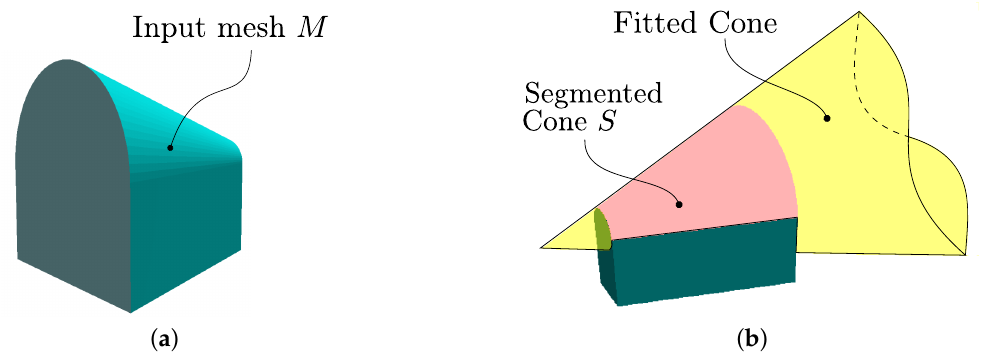
Figure 21. Test 1. Cone fitting test using dihedral angle-based extraction. Pink: segmentation. Yellow: cone fitting.